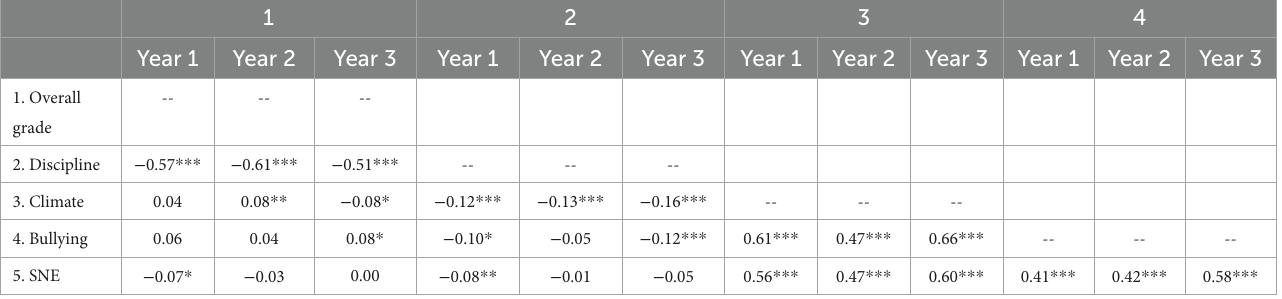
TABLE 6 Pearson’s correlations among continuous study variables.